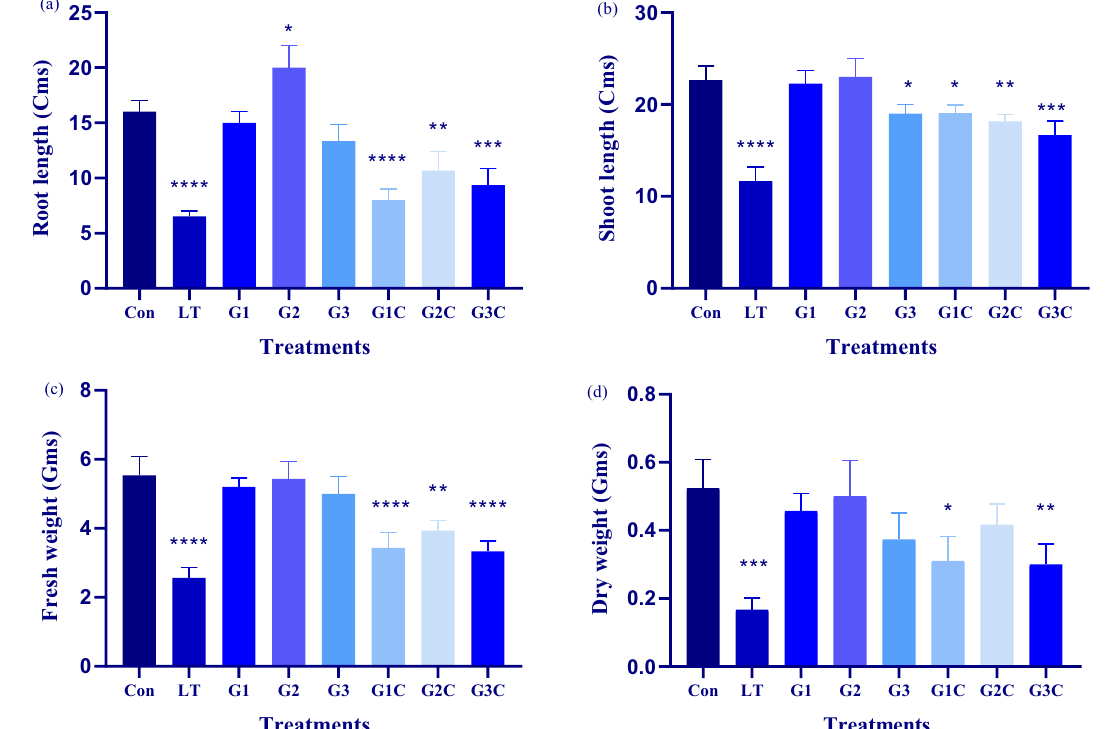
Figure 1. Effect of LT stress and different GSH concentrations on growth characteristics: Forty days after sowing seedlings were used for experimentation pertaining to LT stress and exogenously applied GSH. Post 3 days recovery determination of ( a ) root length ( b ) shoot length ( c ) fresh weight and ( d ) dry weight was done. The data depicts the mean and standard deviation of three replicates. Data followed by (*) determines level of significance ( p < 0.05) as predicted by Dunnet’s multiple comparison test. Control (Con): 25/18 °C + 0 mM GSH, Low temperature stress (LT): 10/3 °C + 0 mM GSH, G1: 25/18 °C + 0.5 mM GSH, G2: 25/18 °C + 1 mM GSH,